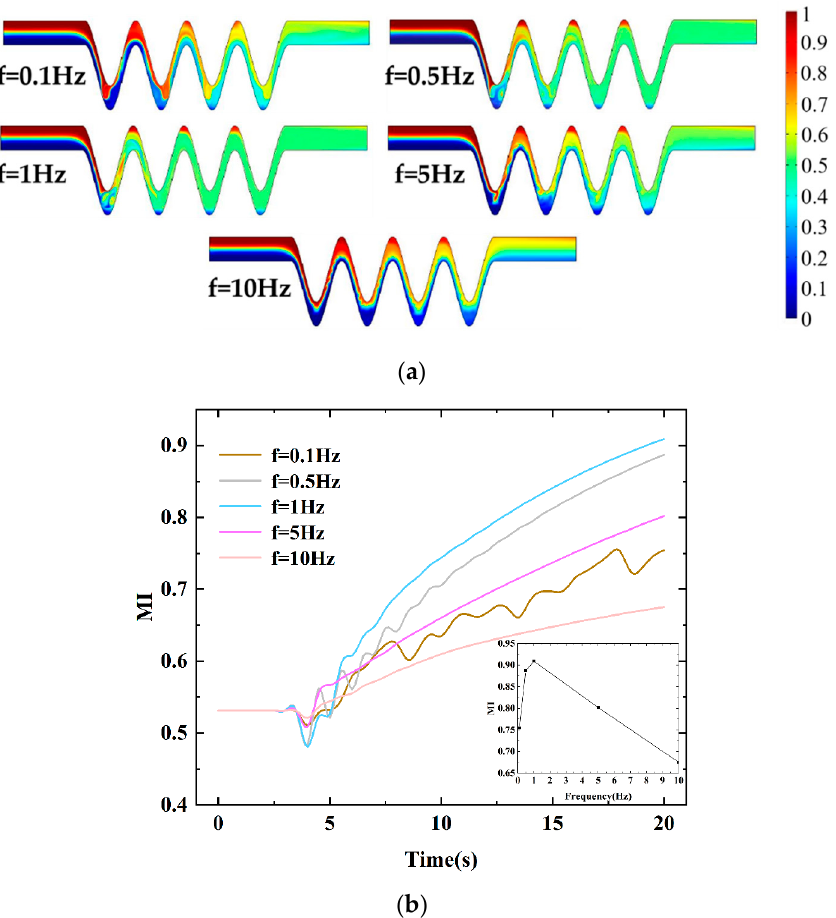
Figure 15. The effect of the frequency:( a ) distributions of concentration surface along the micromixer for different frequencies, ( b ) the mixing index at the outlet for different frequencies within 0-20 s with four pairs of electrodes and a phase shift of pi/4, U 0 = 0.1 mm/s, and V 0 = 2